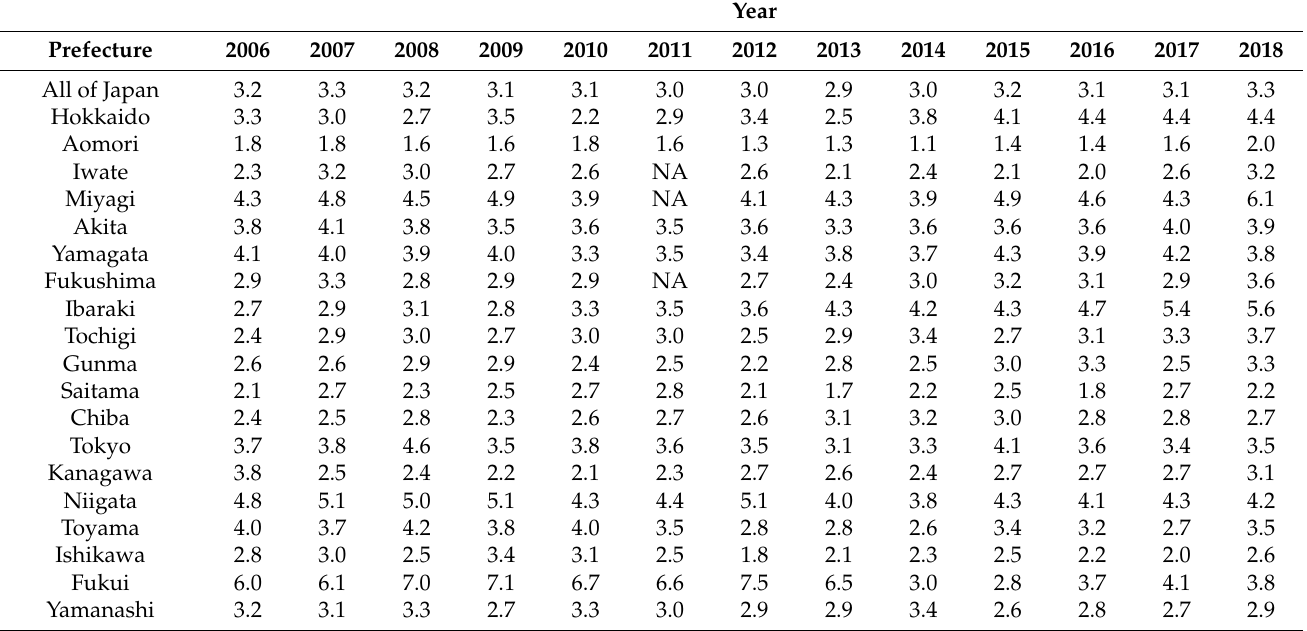
Table 1. Age-standardized prevalence of atopic dermatitis for each prefecture and year for boys.